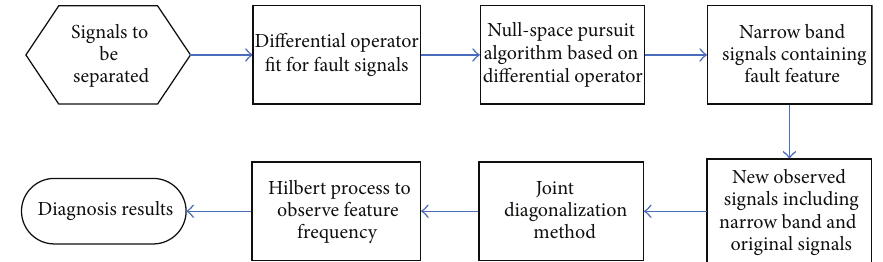
Figure 1: Diagram of the underdetermined BSS algorithm based on NSP.